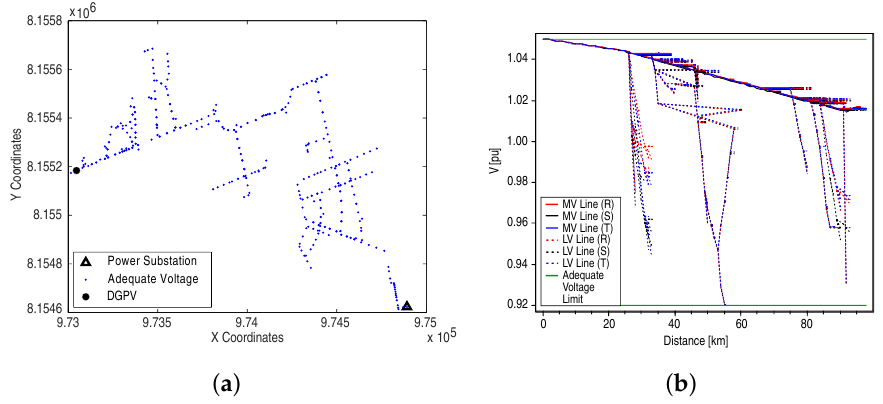
Figure 18. Scenario 6: ( a ) new voltage rating after allocation of DGPV and ( b ) new voltage profile after allocation of DGPV.